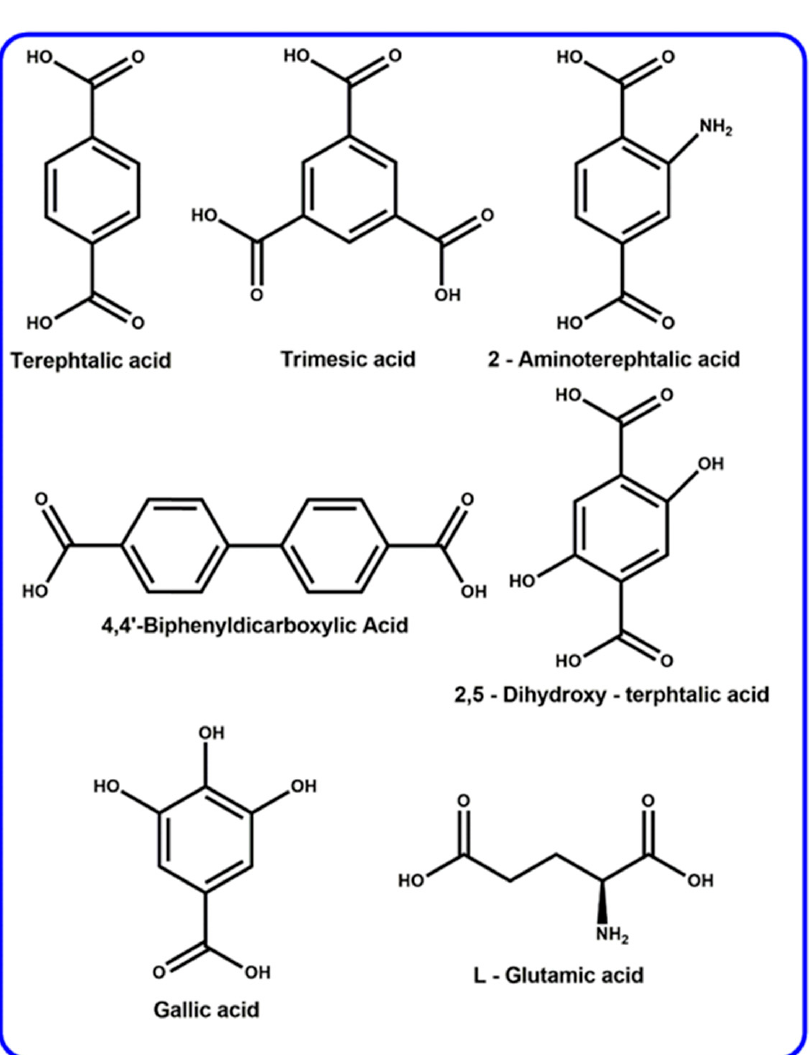
Figure 1. Commonly used synthetic and natural linkers in the synthesis of MOFs